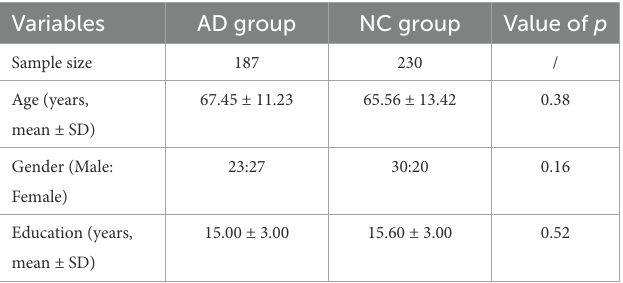
TABLE 1 Patient demographic